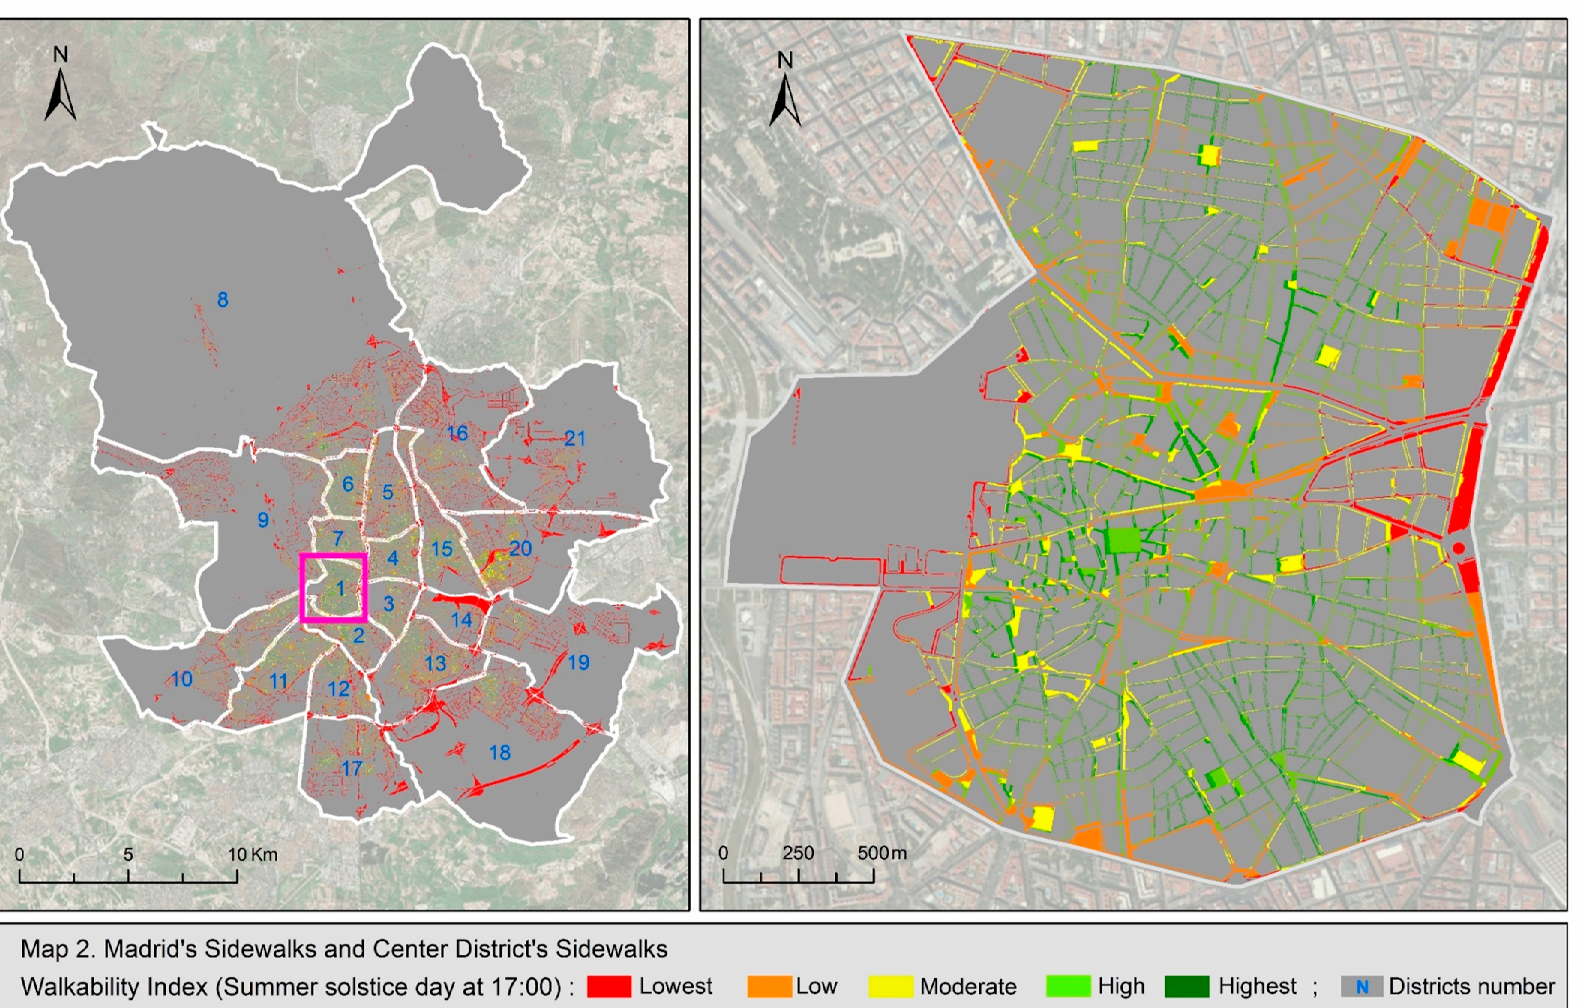
Figure A3. Walkability index results in the entire city and in the central district (detail) at 5 pm on summer